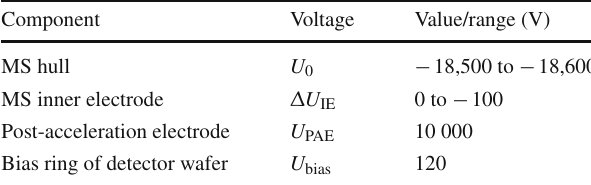
Table 3 The voltage settings used during the gamma-induced back- ground measurements